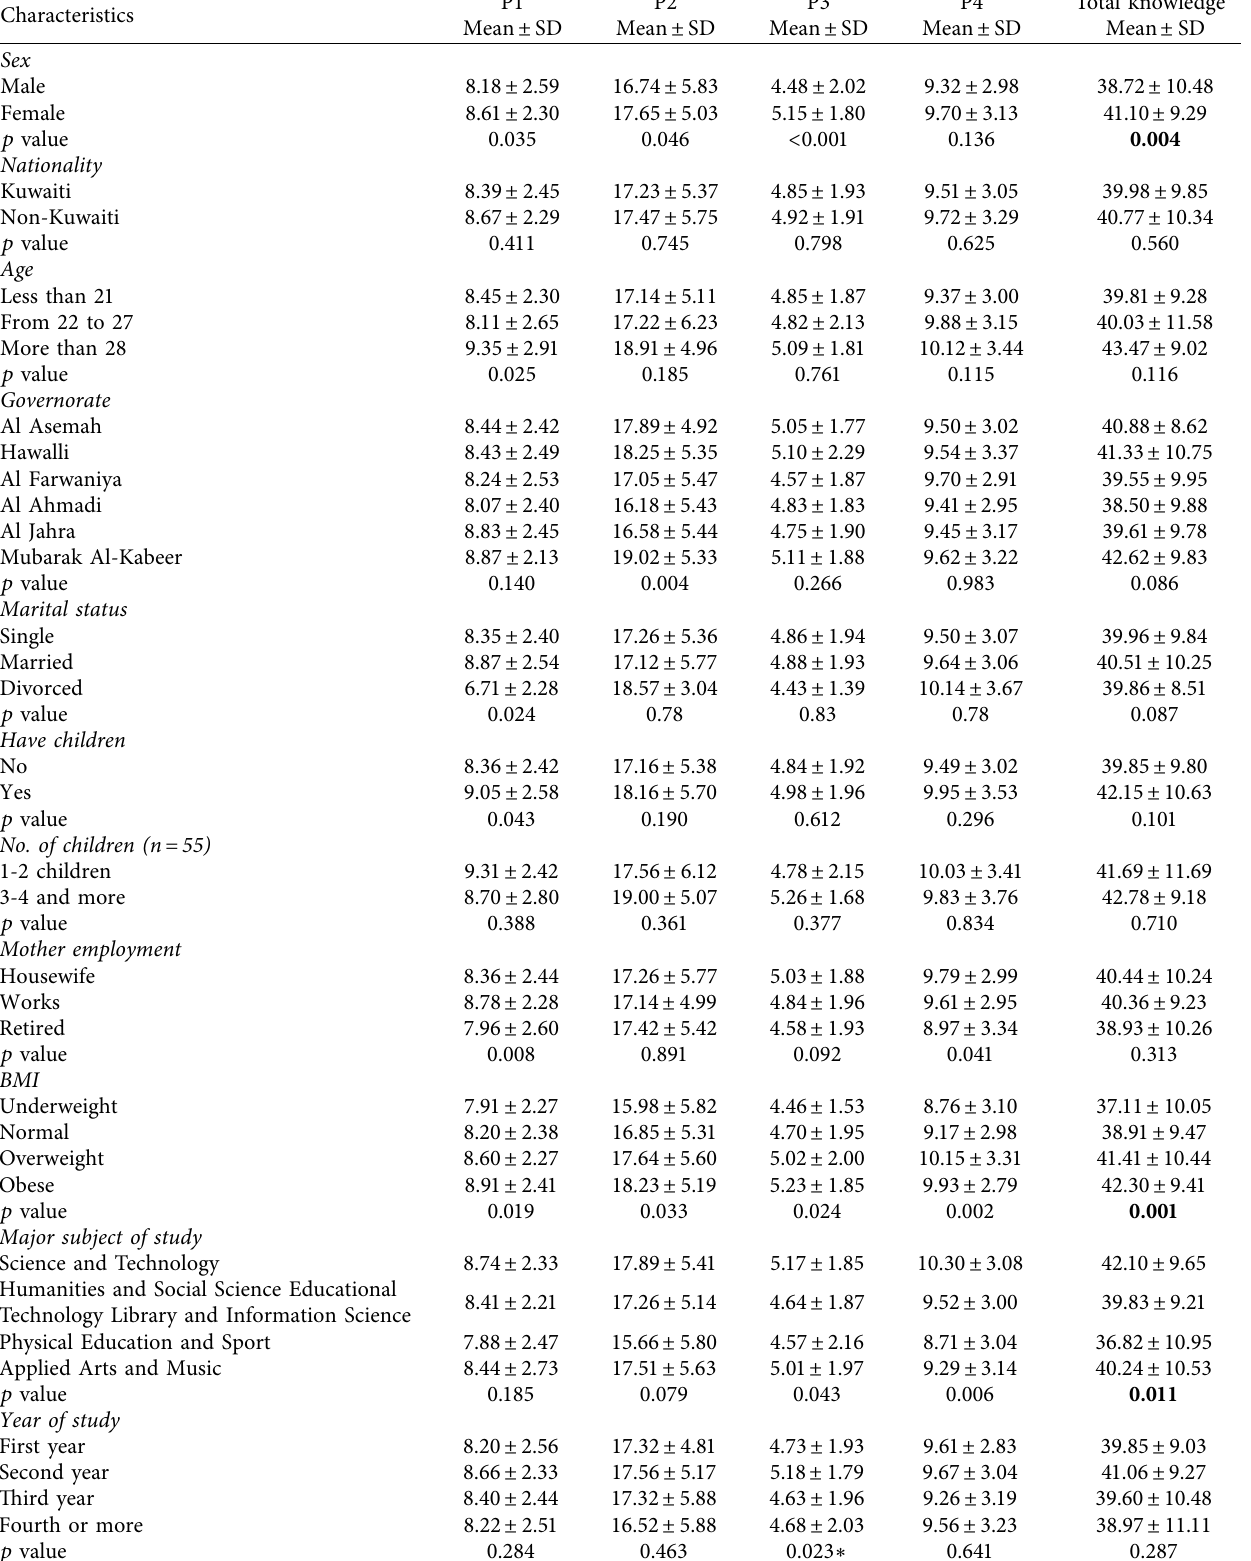
Table 4: Univariate analysis of demographic variance in nutrition knowledge among study